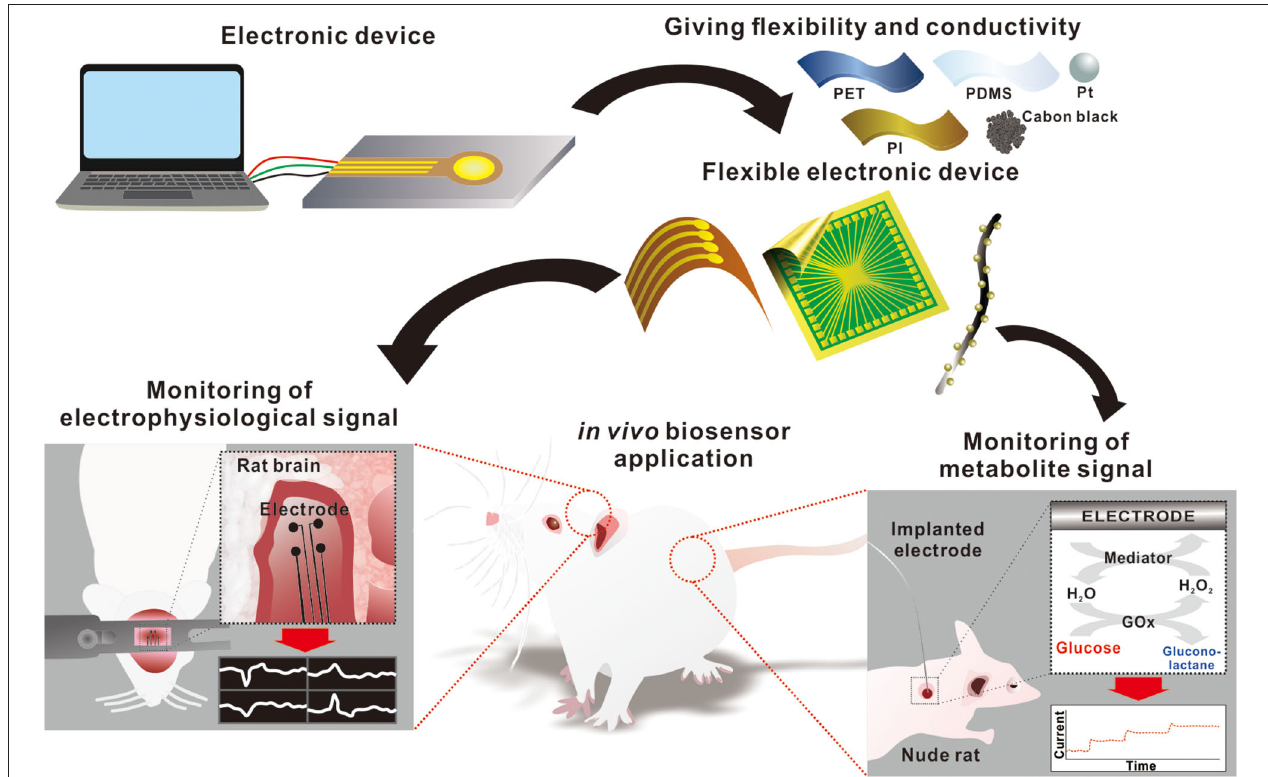
FIGURE 1 | Schematic diagram of flexible electronics for monitoring in vivo